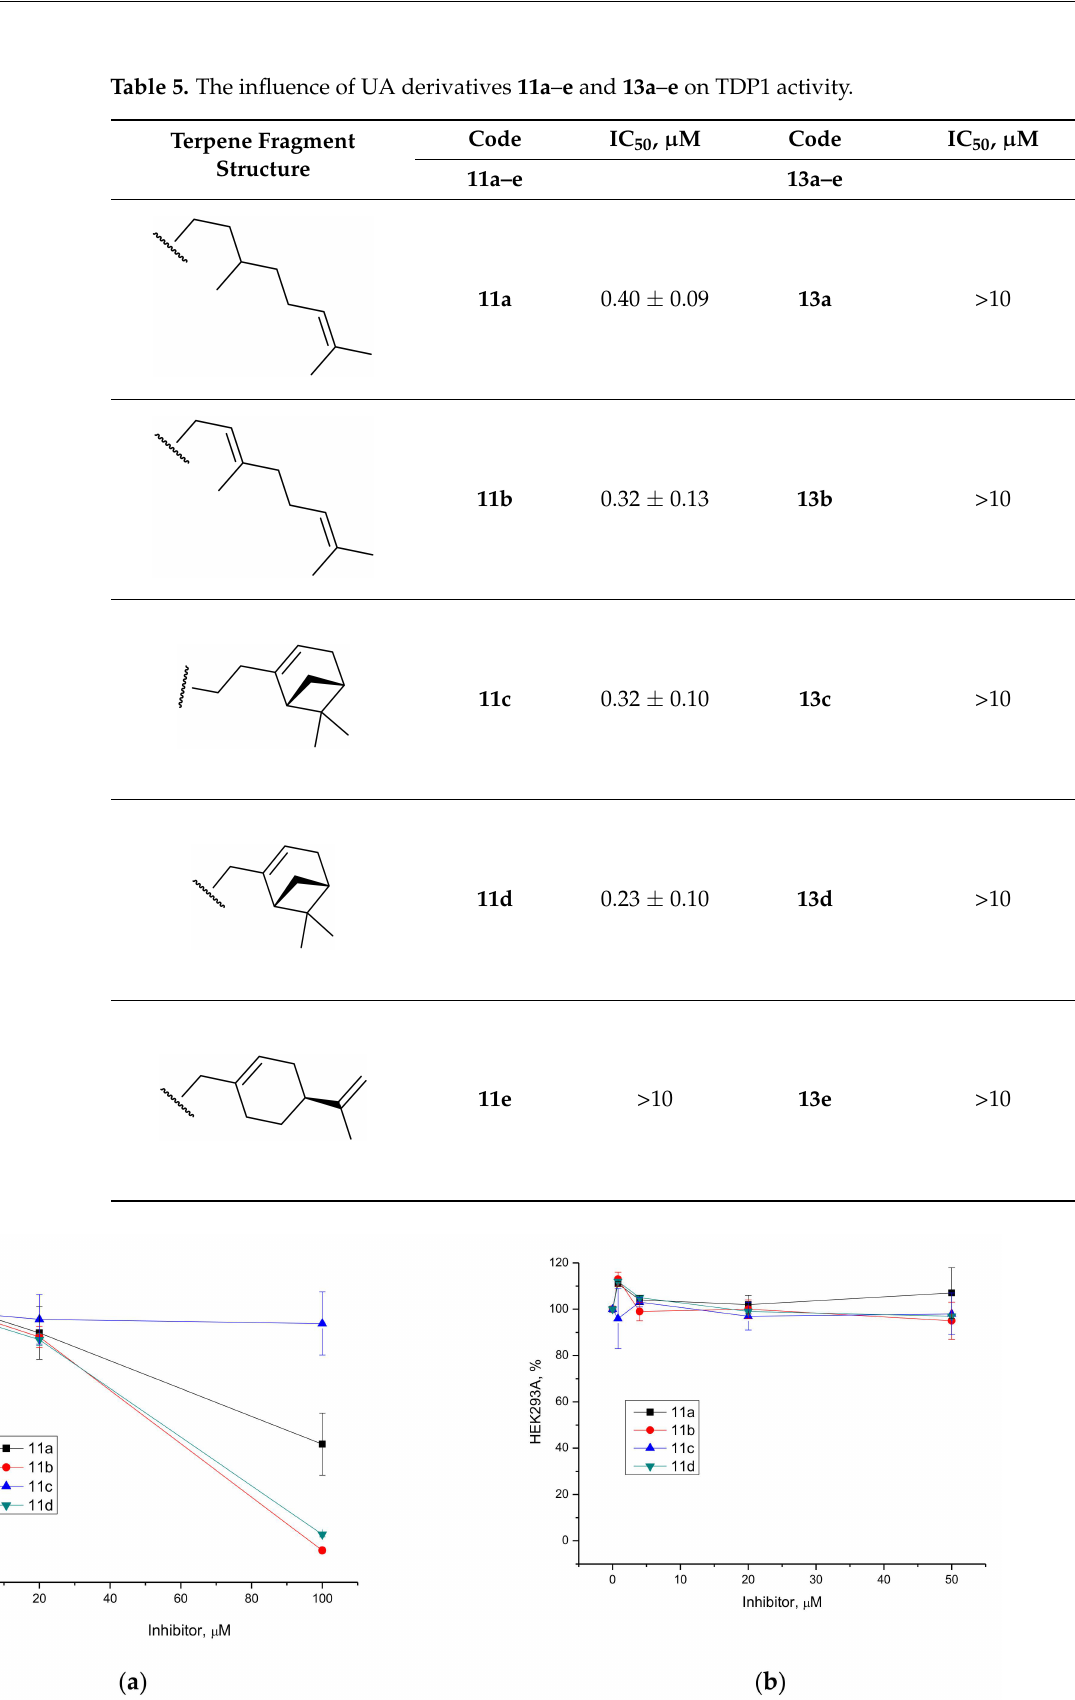
Figure 6. The TDP1 inhibitors’ intrinsic cytotoxicity on HeLa ( a ) and HEK293A ( b ) cells—dose-dependent